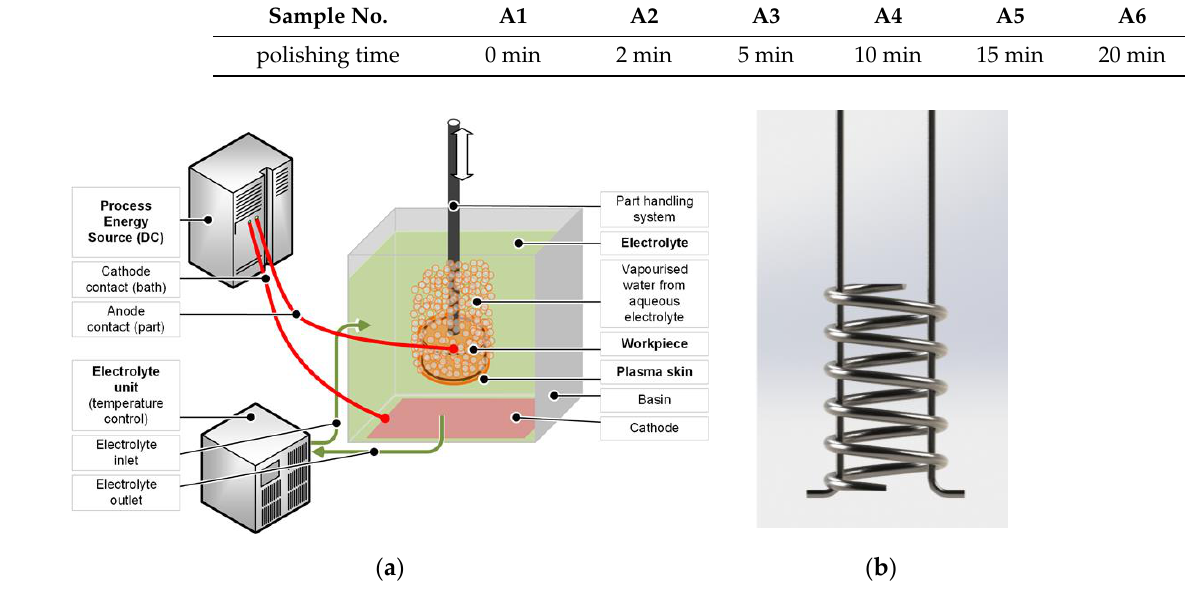
Figure 2. ( a ) Schematic illustration of the experimental PeP setup and ( b ) rendering of the sample